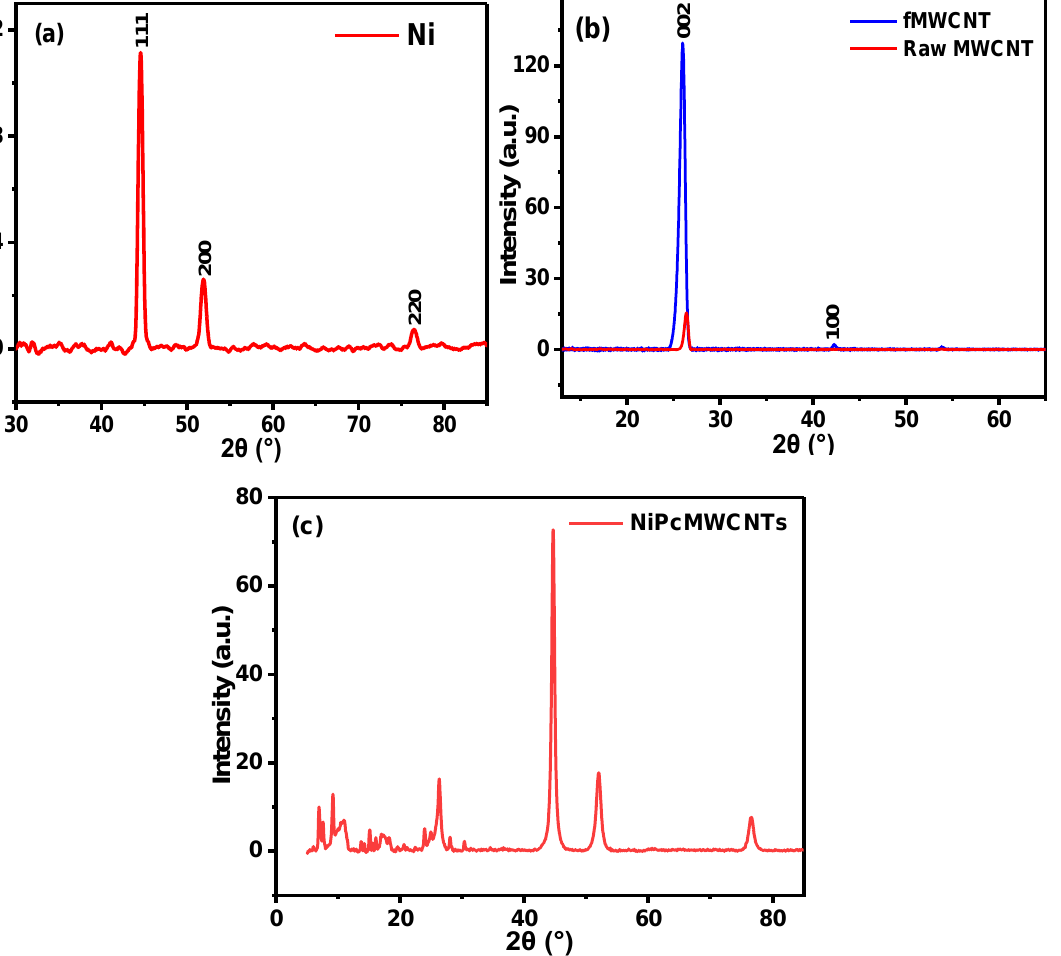
Figure 2. XRD spectra of ( a ) NiNp, ( b ) rMWCNTs and fMWCNTs, and ( c ) NiPcMWCNTs nanocomposite.